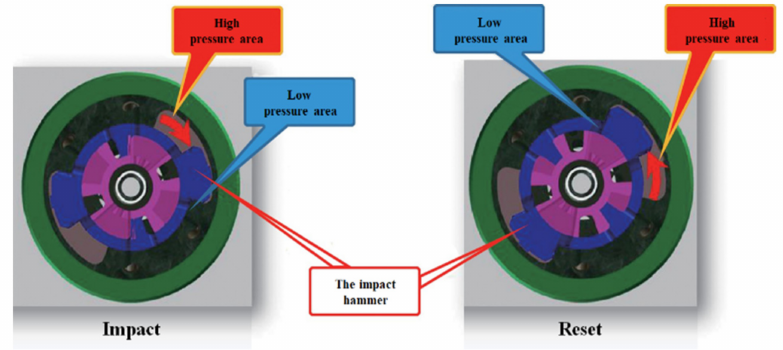
Figure 1. Working diagram of a composite impactor (Su 2019)